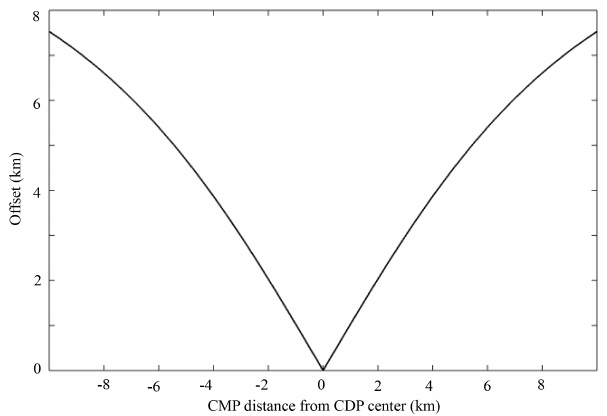
Figure A1. The regular offset distribution in a CDP bin for DMO corrections calculated from a DMO formula (see Hale, 1991; Fowler, 1998). The offset range is considered to be 0–8km; the av- erage velocity is considered to be 5500ms − 1 in order to be repre- sentative of crystalline rocks. The recording length is 4s with a sam- pling rate of 2ms (similar to Chibougamau high-resolution seismic surveys, see Table 1). Target depth is located at